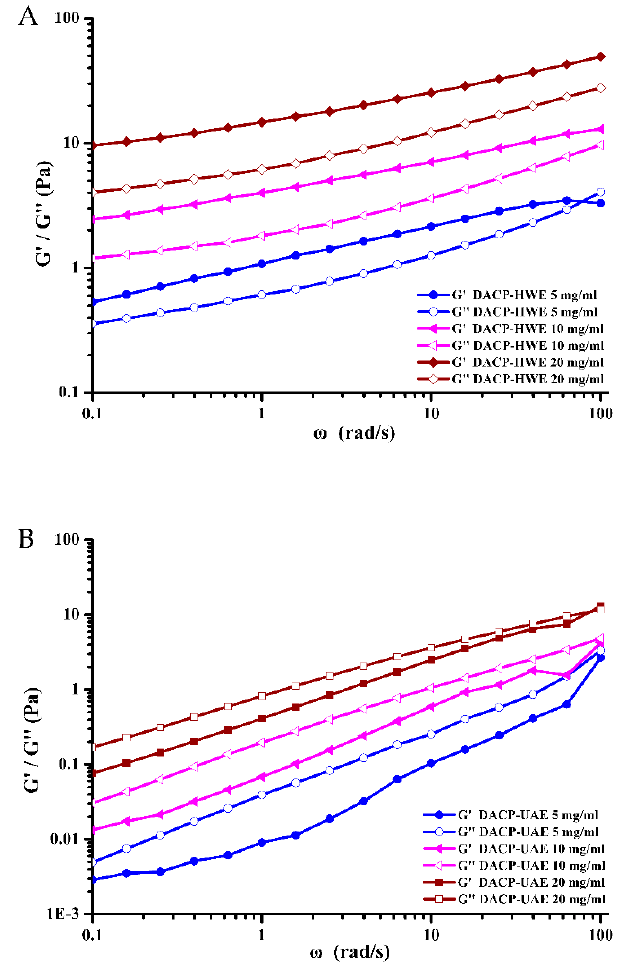
Figure 7. Dynamic storage modulus (G’) and loss modulus (G”) with oscillatory frequency sweeps of ( A ) DACP-HWE solutions with different concentrations (5, 10, 20 mg/mL) and ( B ) DACP-UAE solutions with different concentrations (5, 10, 20 mg/mL).